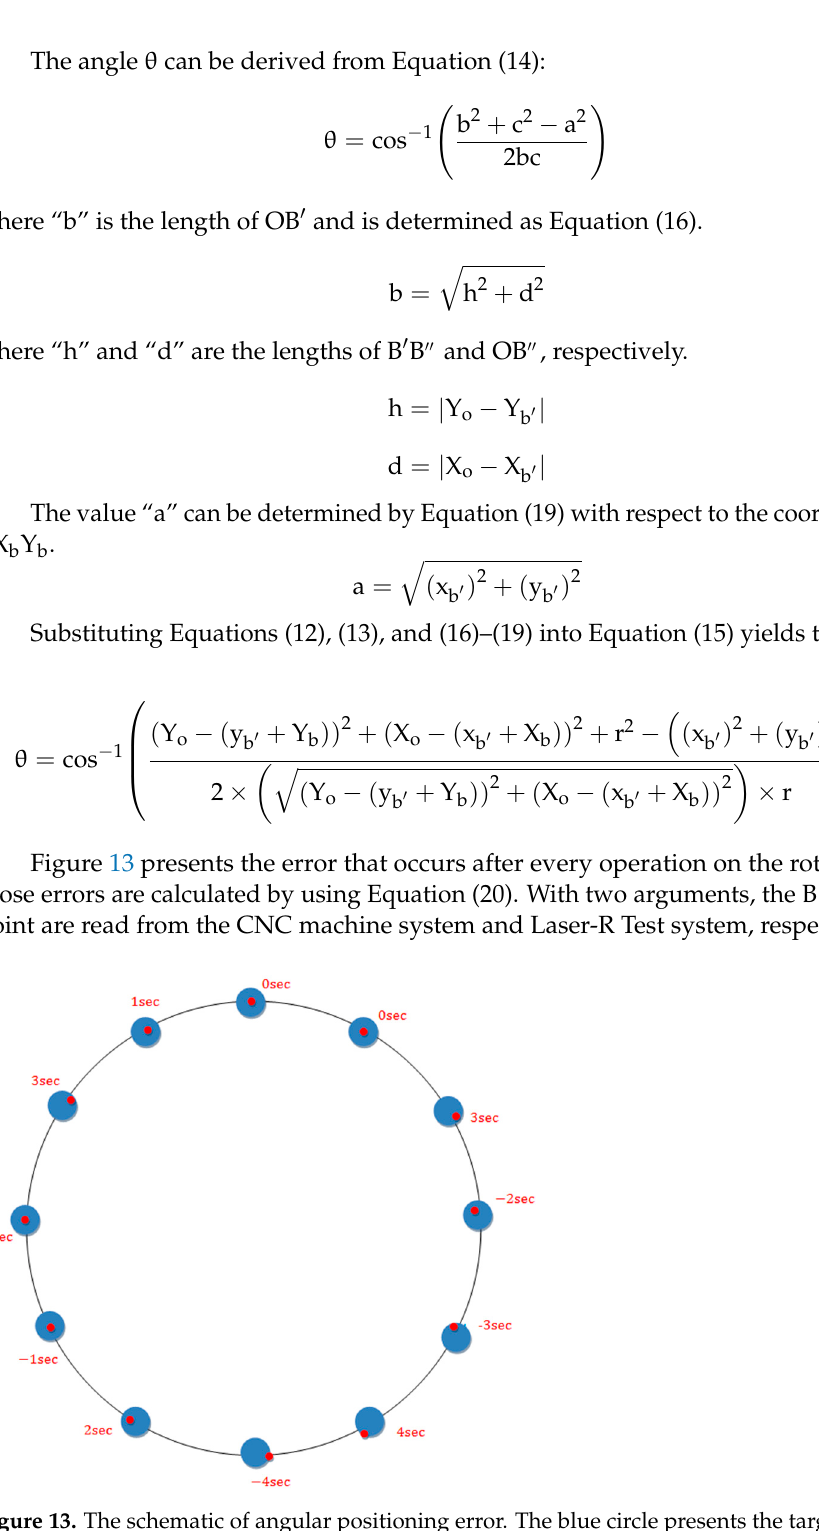
Figure 13. The schematic of angular positioning error. The blue circle presents the target position of the machine that should arrive; the red circle presents the actual position of the machine’s moves.